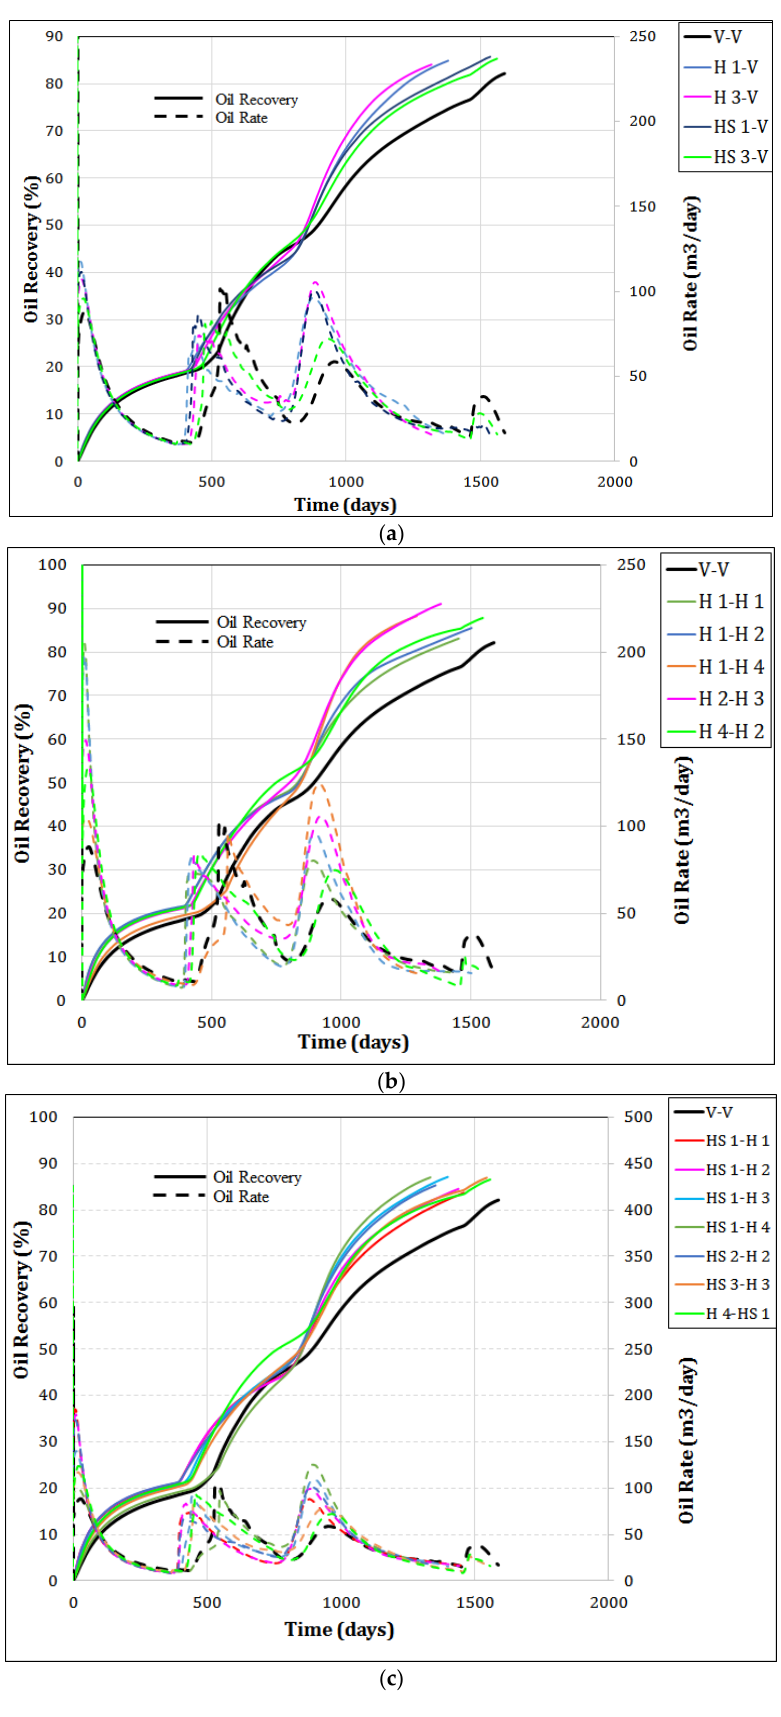
Figure 1. Oil production performance of several well combinations belonging to Category